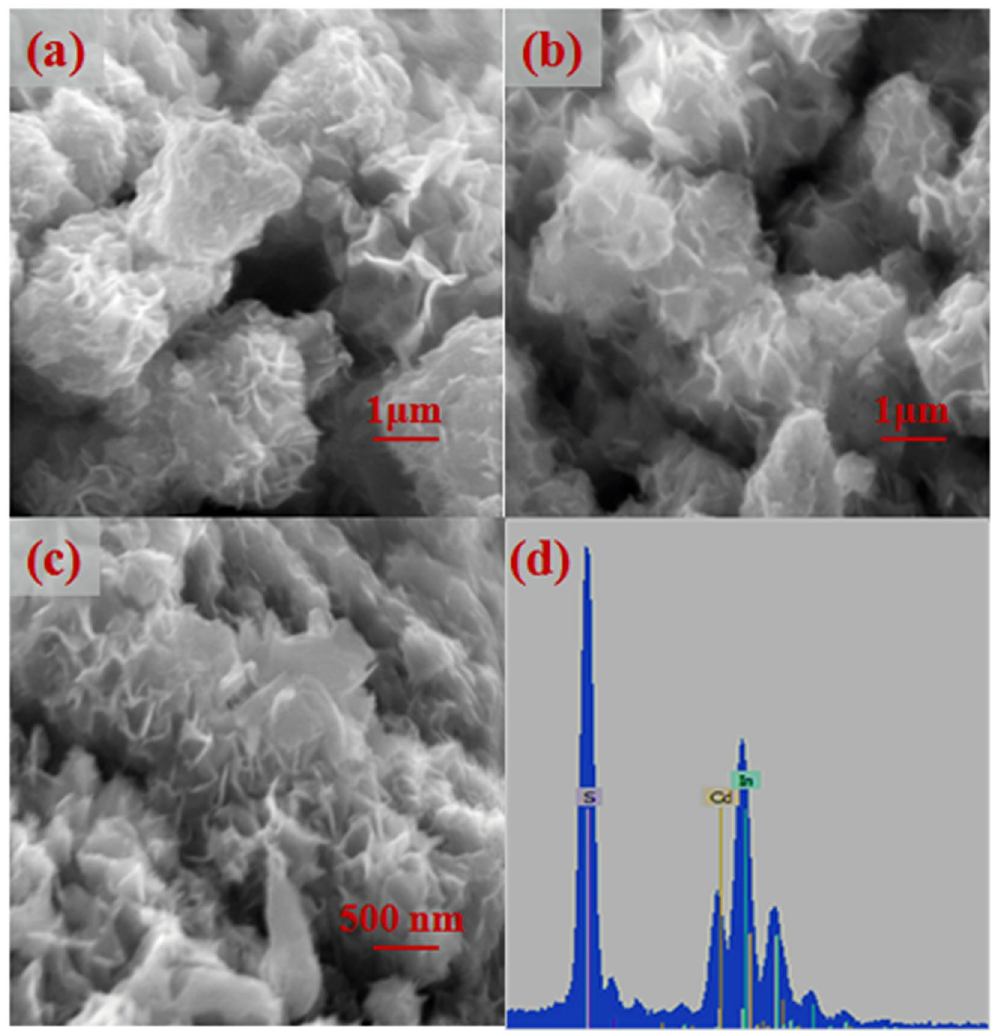
Figure 5. SEM images of CdIn 2 S 4 sample synthesized at 160 °C for 12 h ( a–c ) and EDX pattern of CdIn 2 S 4 sample ( d ).